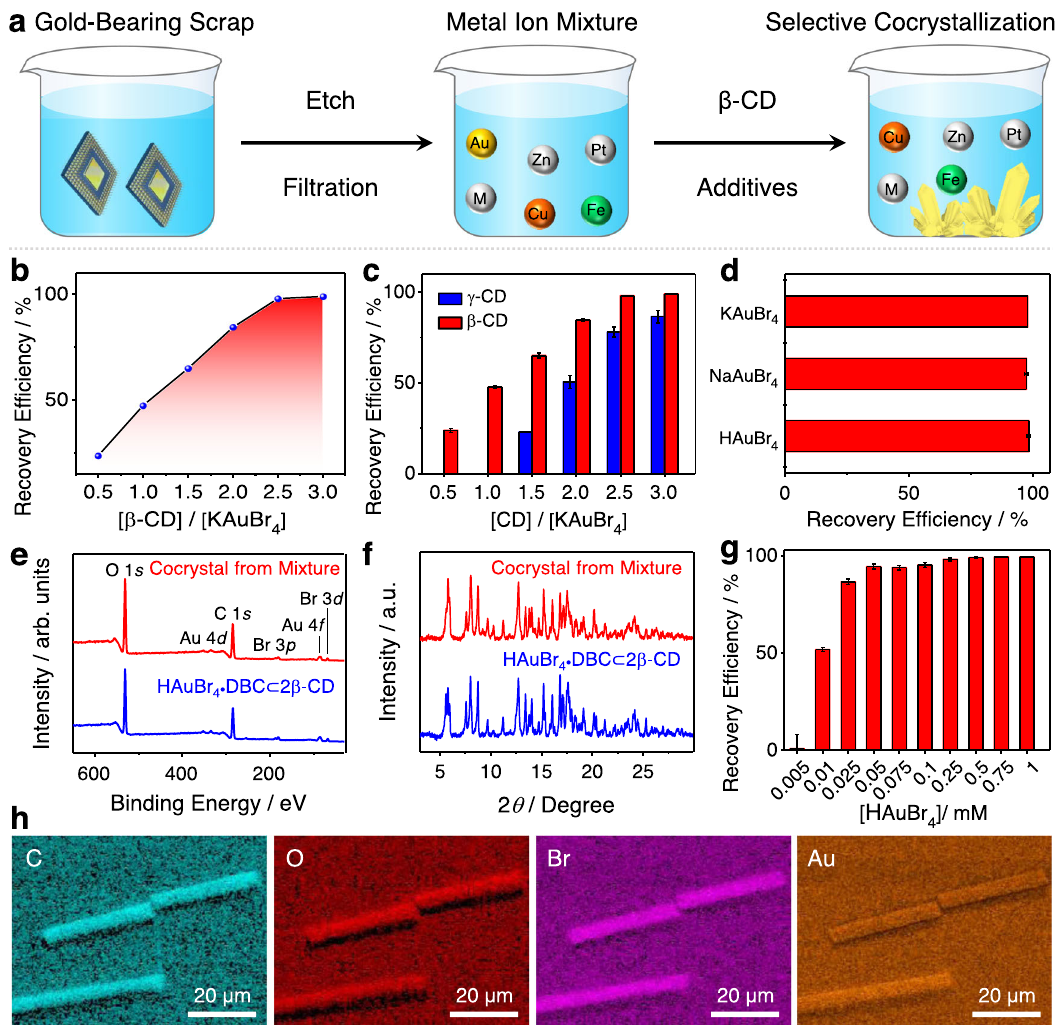
Fig. 5 | Gold recovery from electronic scrap based on additive-induced supra- molecular polymerization. a Schematicdiagram of the selective recoveryof gold from gold-bearing electronic waste using β -CD and additives. b Effect of the β -CD- to-[AuBr 4 ] − ratio on the gold-recovery ef fi ciency. c Effect of the CD ’ s size on the gold-recovery ef fi ciency at different molar ratios. The error bar represents the standard deviation of two independent measurements. d Effect of changing the counter cation associated with the [AuBr 4 ] − anion on the gold-recovery ef fi ciency. The error bar represents the standard deviation of two independent measure- ments. e XPS Spectra of HAuBr 4 ·DBC ⊂ 2 β -CD cocrystals (blue), and the